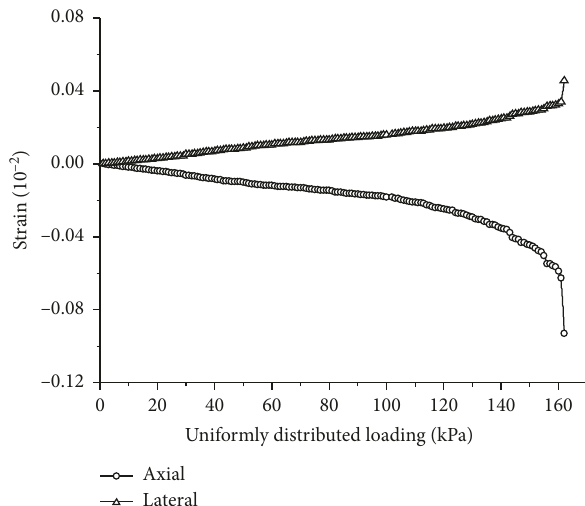
Figure 7: Changes of axial and lateral strains with increase of uniformly distributed loading.